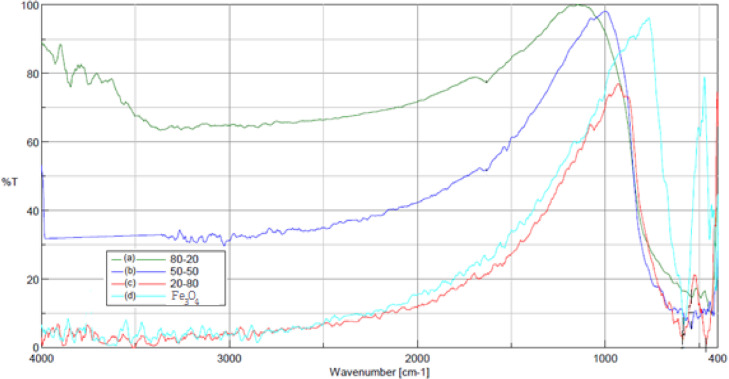
FT-IR spectrum (a) TiO2/Fe3O4 (80/20) (b) TiO2/Fe3O4 (50/50), (c) TiO2/Fe3O4 (20/80), (d) Fe3O4.